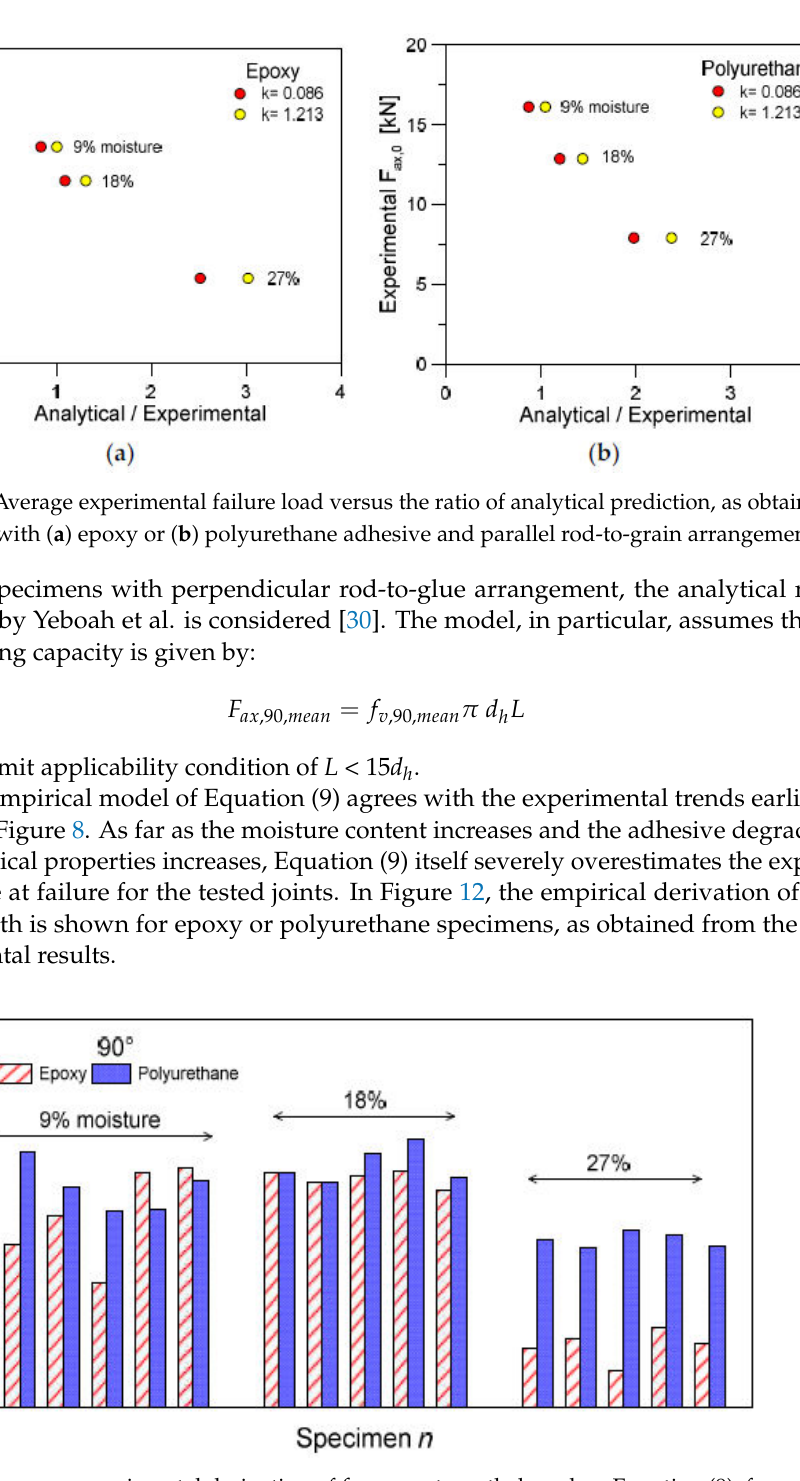
Figure 12. Inverse experimental derivation of f v,90,mean strength, based on Equation (9), for epoxy or polyurethane specimens with perpendicular rod-to-glue